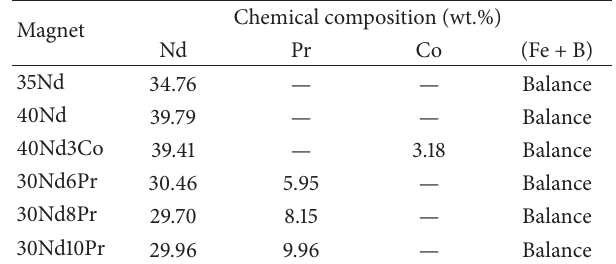
Table 1: Chemical compositions of the magnets tested in 3.5% NaCl solution at 25 ∘